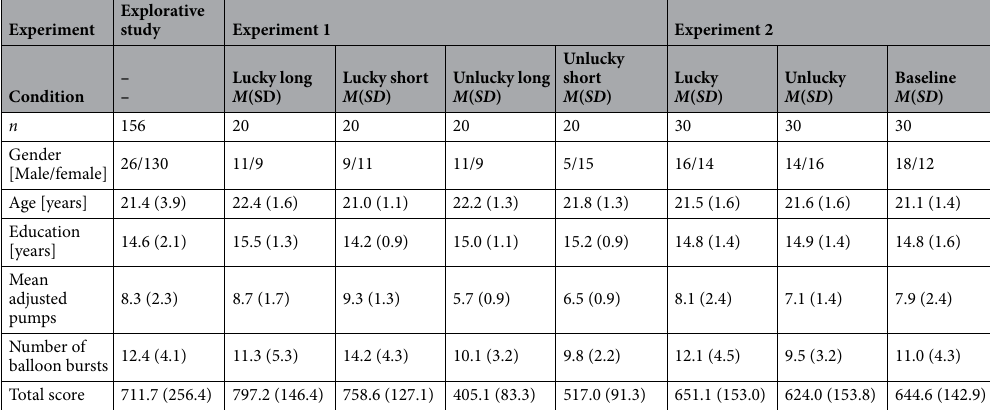
Table 1. Descriptive data of demographic variables and BART performance in Experiments 1–2 and in an explorative study presented in the Supplementary Material. In Experiment 1, BART variables were calculated for the whole task (30 balloons), which included the initial phase with experimental manipulation (biased balloon characteristics). In Experiment 2, BART variables were calculated for the subsequent phase (30 unbiased